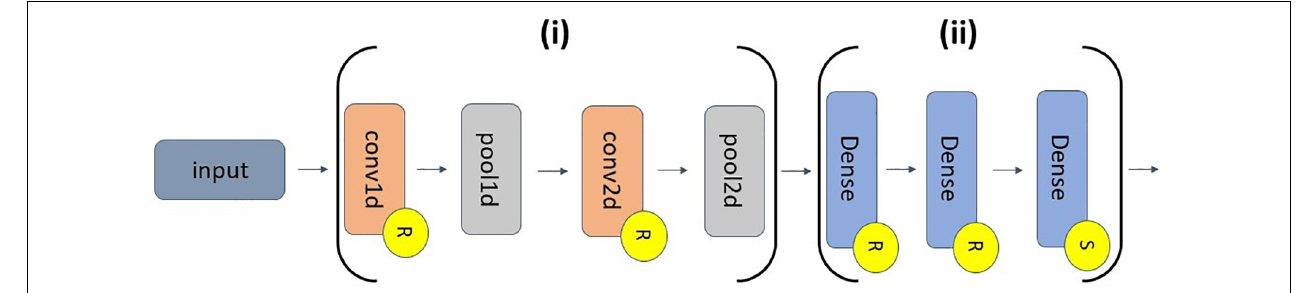
FIGURE 2 | CNN architecture. The feature extraction and classifier segments of the classifier are indicated by Sections (i) and (ii), respectively. (i) has of a 1D convolutional (conv1d) layer (30 filters, length of 200, stride of 1), a 1D max pooling (pool1d) layer (pooling size of 15, stride of 10), a conv2d layer (400 filters, 30 × 25 filter size, stride of 1 × 1), and a pool2d layer (pooling size of 10 × 1, stride of 1 × 2). (ii) has 2 dense layers (500 nodes) and an output dense layer (5 nodes). Layers with an “R” or an “S” have ReLU or softmax activation functions,